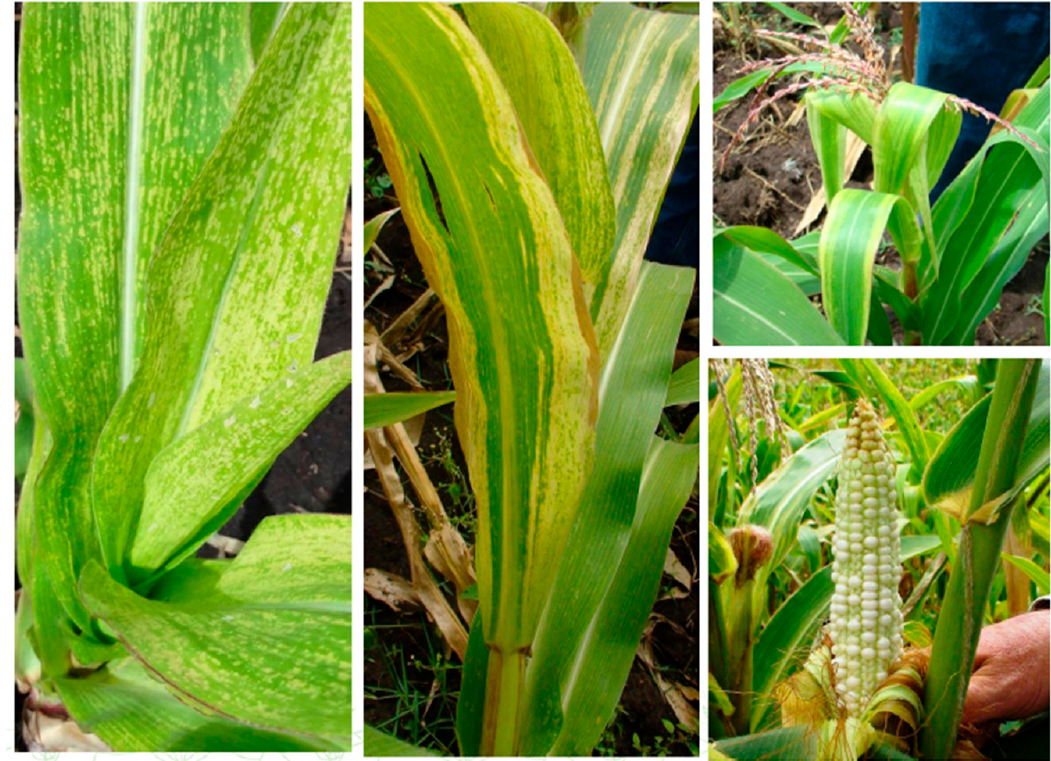
Figure 2. Maize Lethal Necrosis disease symptoms (photo source: Suresh, L.M.). 3. MLN Causative Agents and Disease Management Numerous lines of evidence point out that MLN is often caused by the synergistic co-infection of MCMV and any member of the Portyviridae family [4,17,18]. Synergistic interactions of potyviruses and other viruses have been reported, and in such a scenario, non-potyviruses are the major beneficiaries [19,20]. The increased accumulation of MCMV in co-infected plants is attributed to the presence of potyviruses which bring about unilateral synergism [19,21]. It has been hypothesized that an increased concen-